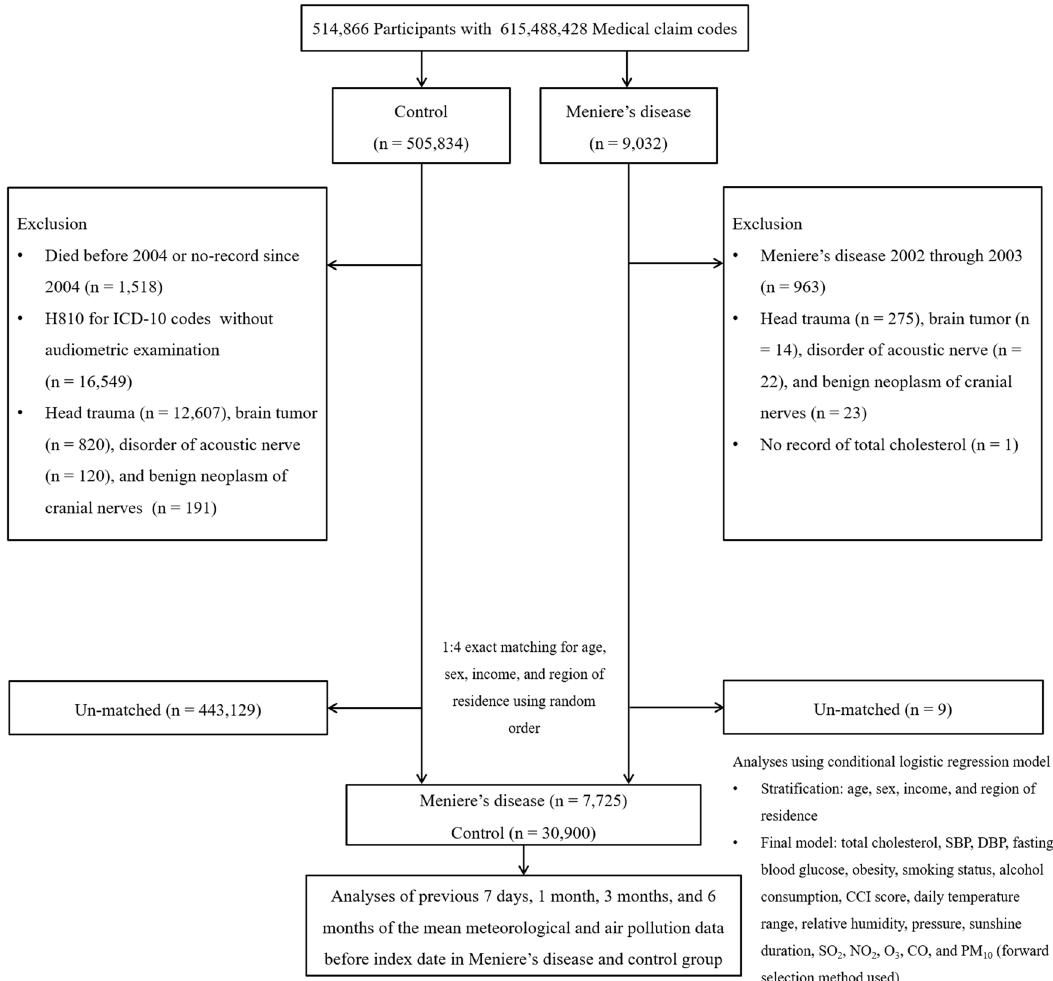
Figure 1. A schematic illustration of the participants’ selection process that was used in the present study. Of a total of 514,866 participants, 6050 of Meniere’s disease participants were matched with 24,200 control participants for age, sex, income, and region of residence. Thereafter, the participants with Meniere’s disease and control participants were matched for the same meteorological and air pollution data before the index